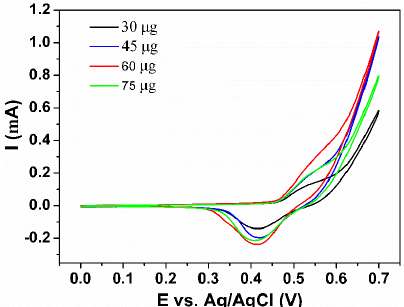
Figure 6. The effect of modification amount on the performance of the electrode.